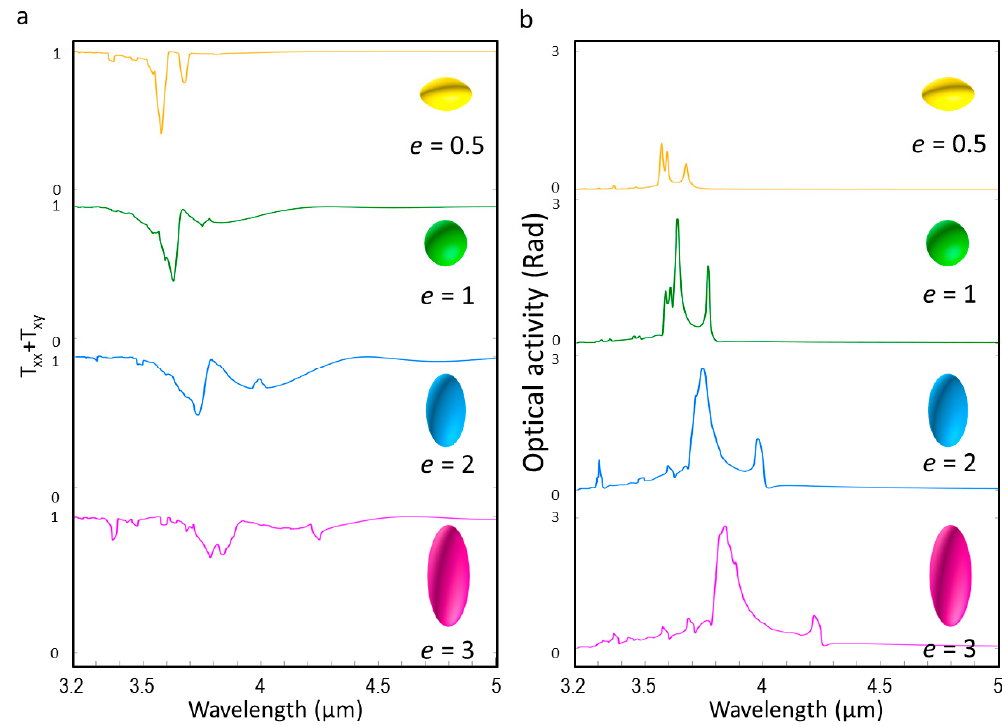
Figure 4. Simulation of transmission and optical activity (OA). ( a ) 8-srs transmission as a function of aspect ratio, e. ( b ) 8-srs OA as a function of aspect ratio, e.